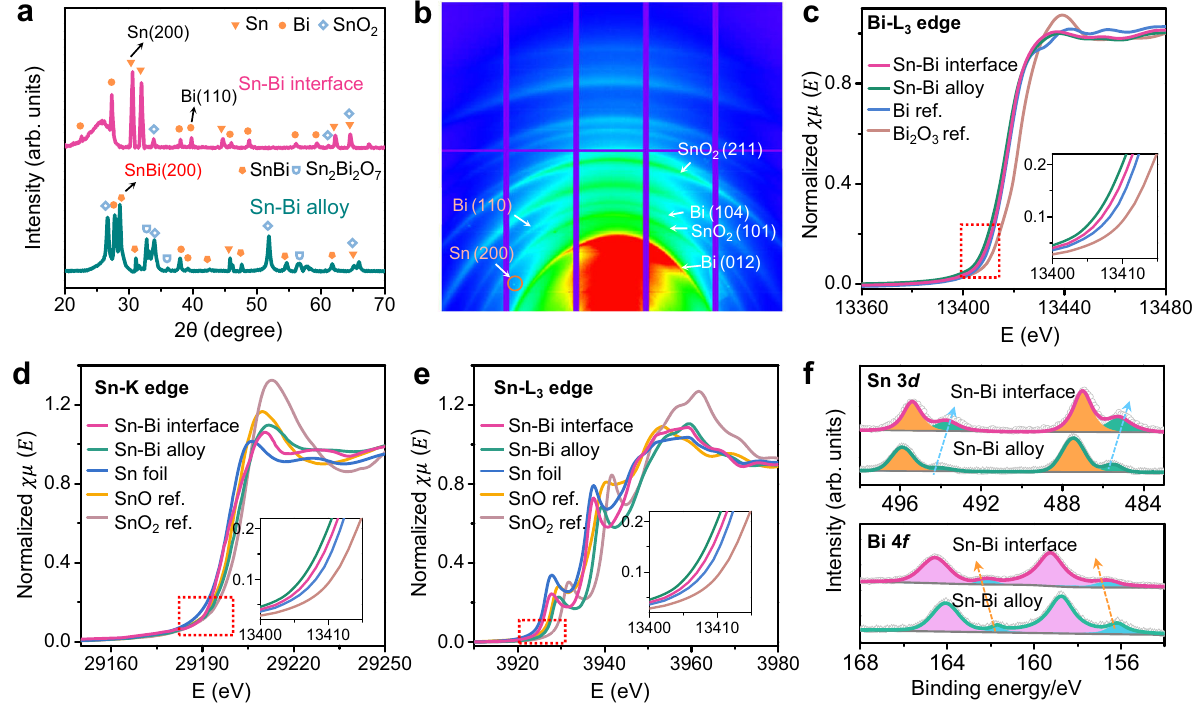
Fig. 3 Crystal structures and electronic structures analysis. a XRD patterns. b Synchrotron 2D-XRD patterns of the Sn – Bi bimetallic interface. c – e XANES spectra of Bi L 3 -edge, Sn K-edge and Sn L 3 -edge. f XPS spectra of Sn 3d spectrum and Bi 4 f spectrum for Sn – Bi interface and alloy. Solid color lines represent the curve fi